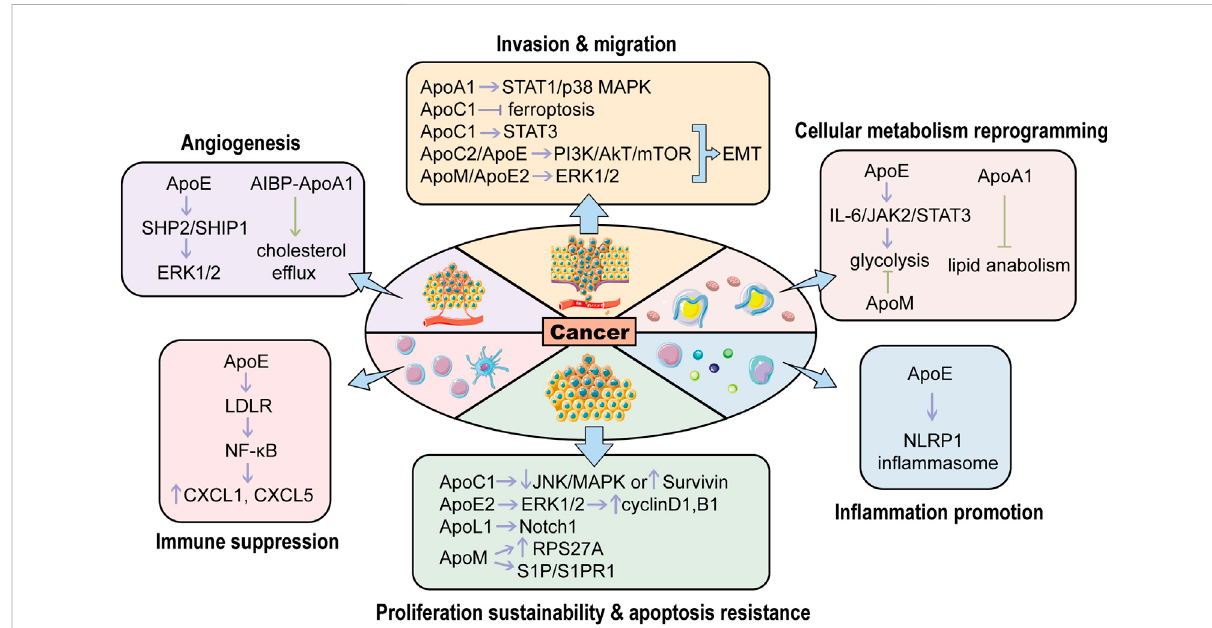
FIGURE 2 The roles of APOs in regulating various hallmarks of cancers. APOs activate or inhibit carcinogenesis through modulating different hallmarks of cancers. The purple arrows represent cancer promotion while the green ones represent cancer suppression. (EMT, epithelial-mesenchymal transition; NLRP1 in fl ammasome: Nod-like receptor protein one in fl ammasome; RPS27A, ribosomal protein S27A; S1P, Sphingosine-1-Phosphate; S1PR1, sphingosine 1-phosphate receptor one; LDLR, low-density lipoprotein receptor; SHP2: SH2 domain-containing phosphatase two; SHIP1, Src homology two domain-containing inositol phosphatase one; AIBP, ApoA1 binding protein). This fi gure is partially made using Servier Medical Art